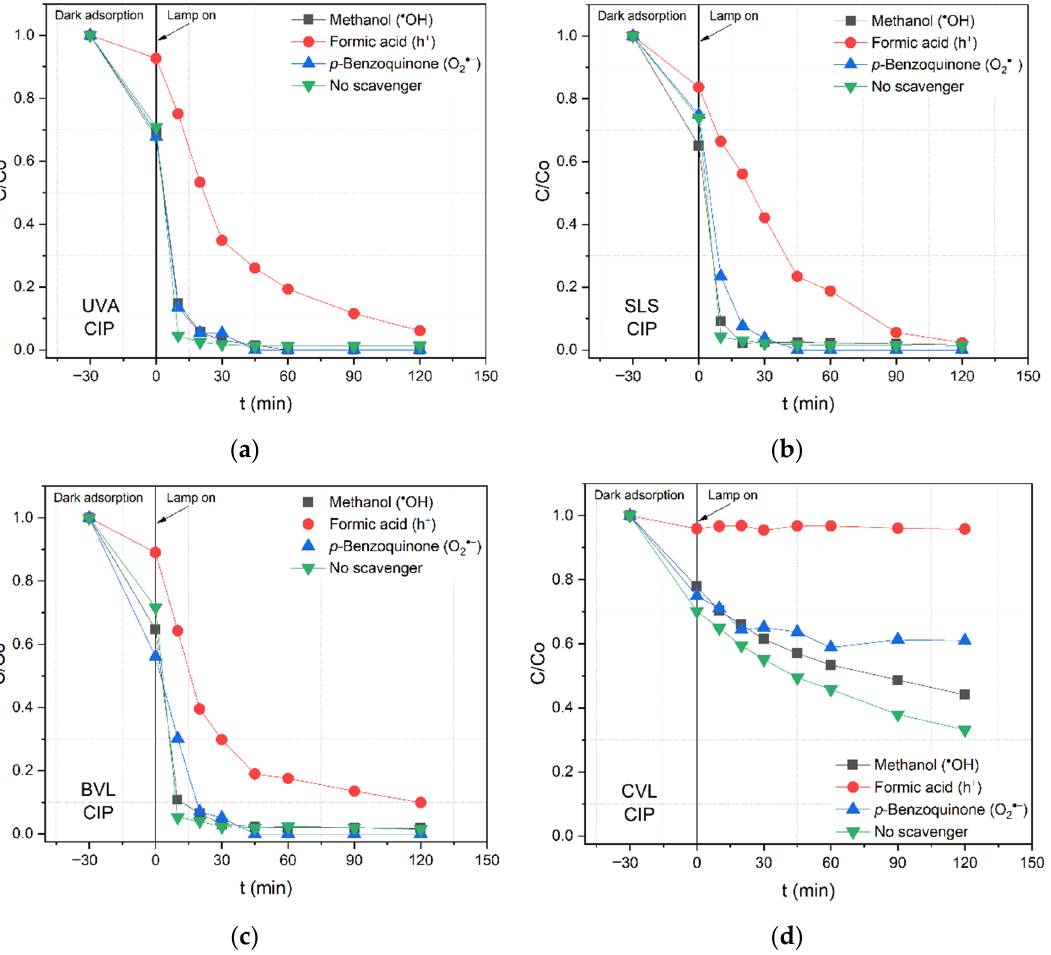
Figure 6. Photocatalytic degradation of ciprofloxacin (CIP) by N/TiO 2 /rGO with 0.25 wt.% of rGO material in the presence of different scavenger agents under ( a ) UVA light, ( b ) solar light simulator (SLS), ( c ) blue visible light (BVL), and ( d ) cold visible light (CVL). The photocatalytic degradation of diclofenac (DCF) by N/TiO 2 /rGO with 0.25 wt.% of rGO material in the presence of scavenger agents under different irradiation sources is displayed in Figure 7. It is observed that formic acid diminishes the photocatalytic activ- ity, indicating that the holes ( h +) play a significant role in the DCF removal. However, in the removal of DCF, the role of superoxide (O 2 °¯) and hydroxyl radical (°OH) are also significant. Under BVL irradiation, it can be seen that DCF removal is not entirely achieved in any scavenging agent presence, indicating that all ROS are important for pol- lutant removal under less energetic wavelengths. Again, it is noticed that the photocata- lytic mechanism remains independent of the irradiation wavelengths.